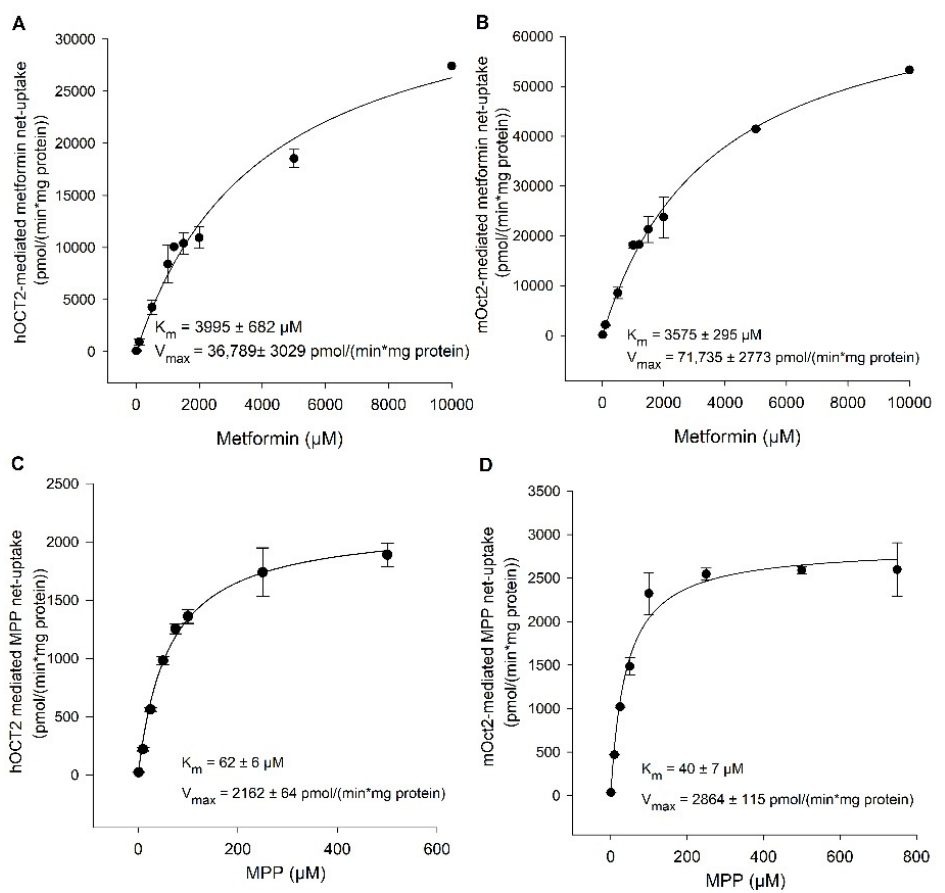
Figure 2. Kinetics of ( A ) hOCT2-, ( B ) mOct2-mediated 14 C-metformin transport and ( C ) hOCT2-, ( D ) mOct2-mediated 3 H-MPP transport. Human and mouse transfected HEK293 cells were incubated for 1 min at 37 ◦ C in the presence of 3 H-labeled (2 nM) and increasing concentrations of unlabeled MPP or 2 min in the presence of 14 C-labeled (1 µ M) and increasing concentrations of unlabeled metformin. Transporter specific net uptake was fit to the Michaelis–Menten equation to obtain the affinity constant K m and maximum transport velocity V max by non-linear regression analysis using Sigma Plot 13.0 software. Each data point represents the mean of two independent experiments carried out in triplicate ± average